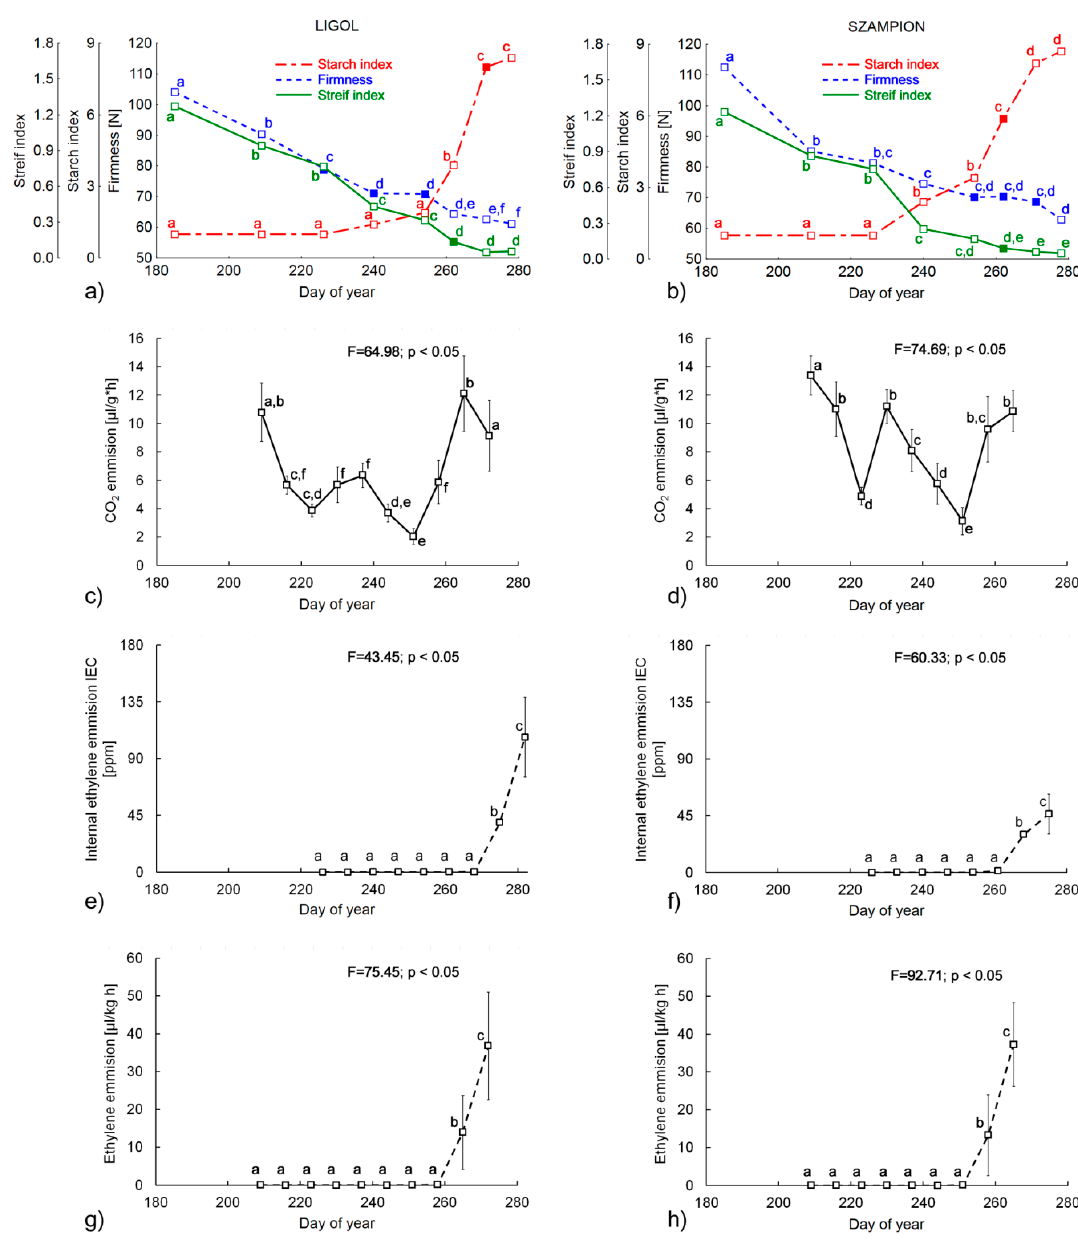
Figure 2. The changes of ( a , b ) Streif Index, Starch Index and Firmness ( c , d ) carbon dioxide emission, ( e , f ) internal ethylene concentration (IEC) and ( g , h ) the rate of ethylene production for ‘Ligol’ (on the left) and ‘Szampion’ cultivars (on the right side). The filled markers indicate optimum harvest date found. Bars represent standard deviations. The superscript letters denote no significant differences at p < 0.05.